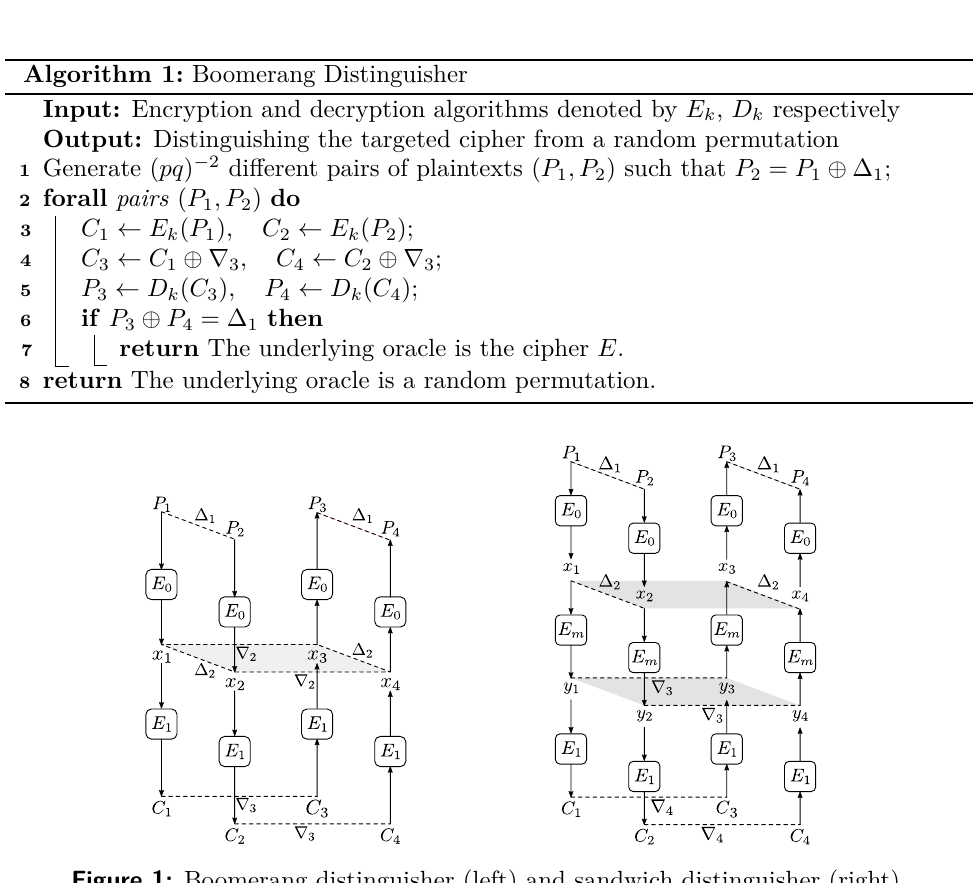
Figure 1: Boomerang distinguisher (left) and sandwich distinguisher